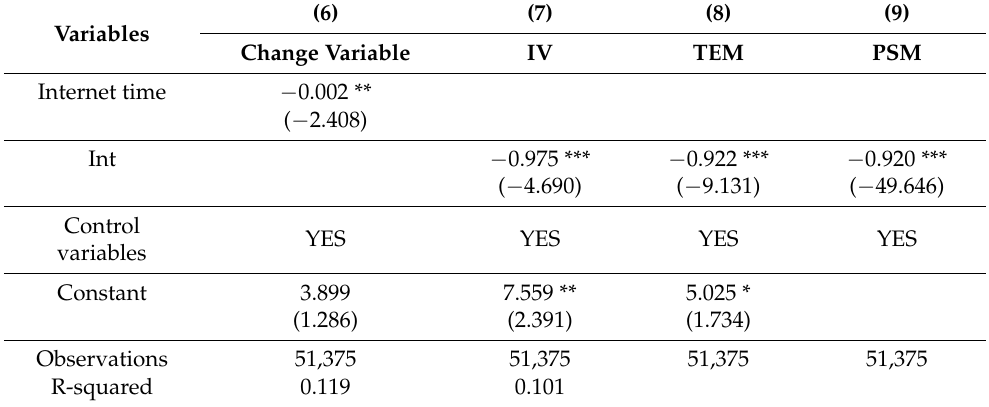
Table 3. Robustness test